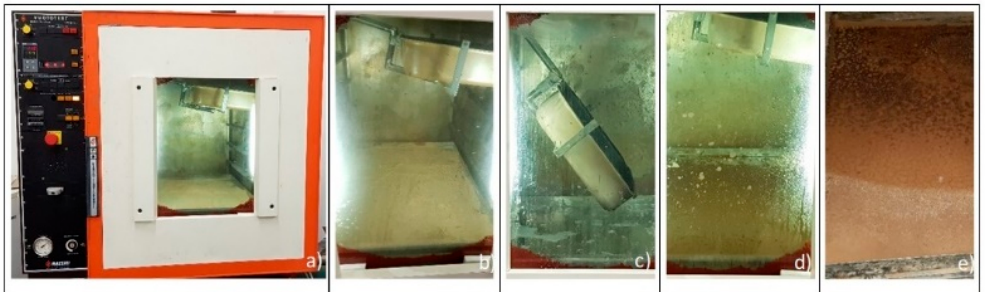
Figure 6. Impregnation process. ( a ) Vacuum furnace with a movable tank, ( b ) preparation with depressurization, ( c ) spillage of the saline solution onto the porous medium, ( d ) impregnation of the porous medium and ( e ) drying in depression .